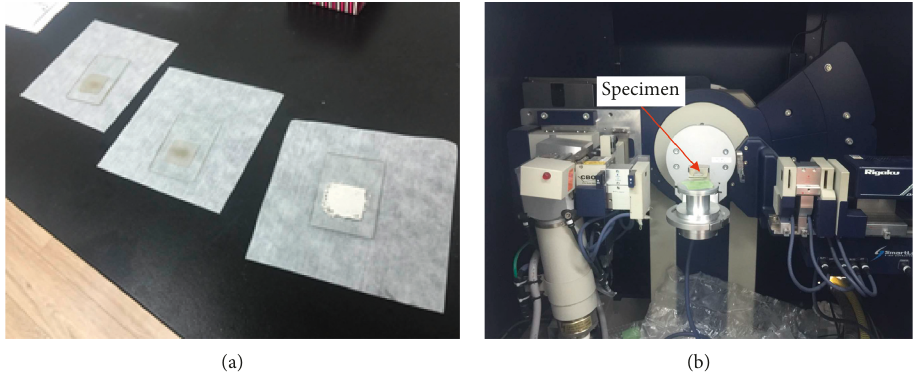
Figure 4: XRD: (a) specimen preparation; (b) equipment.